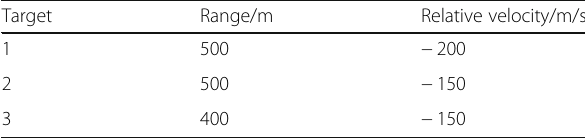
Table 2 Range and relative velocity parameters for three